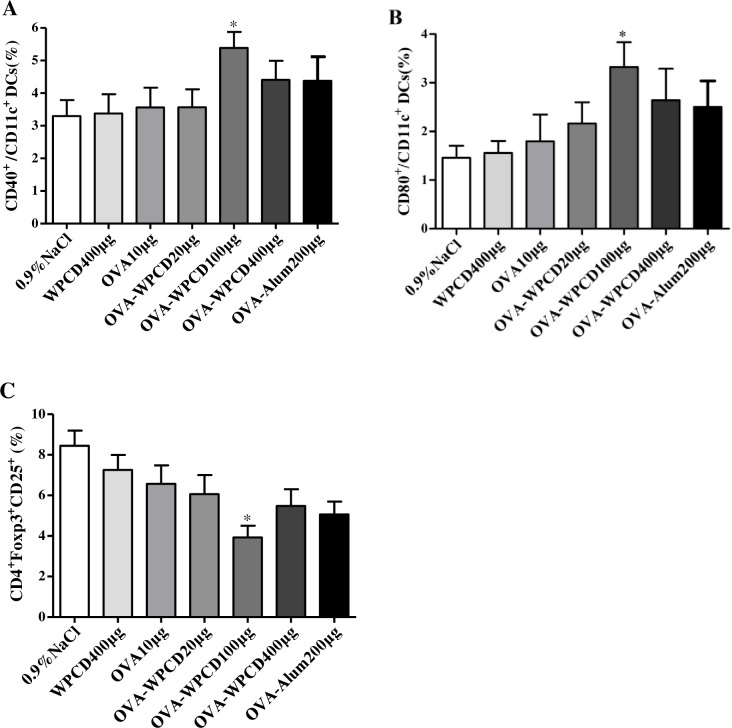
Effects of WPCD on DCs maturation and Treg frequency.On Day 3 or 21 after the first vaccination, cells were separated from the spleen of each group mice and the expression levels of CD11C+CD40+ and CD11C+CD80+ on DCs as well as the frequency of CD4+CD25+Foxp3+ was measured by FCAS. The expressions of CD11C+CD40+
(A) and CD11C+CD80+
(B) on DCs in the spleen on Day 3 after the first vaccination. The frequency of CD4+CD25+Foxp3+ Treg in the total CD4+ T cells in the spleen on Day 7 after the second vaccination (C). Data represent mean ± SD (n = 5) from 3 independent experiments. *P < 0.05 compared with the OVA group.